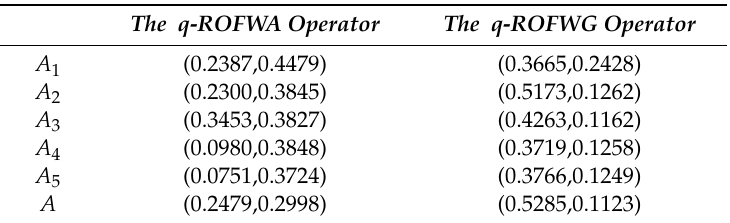
Table 3. The fused values of A i ( i = 1,2,3,4,5 ) and A . The q - ROFWA